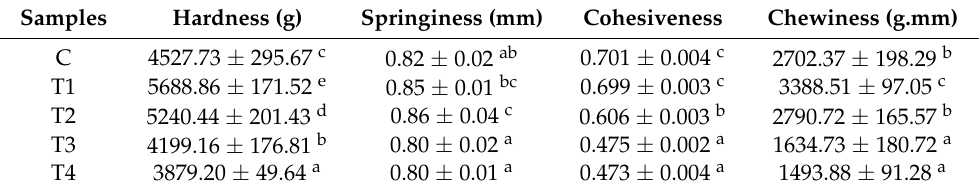
Table 5. Textural properties of cooked lower-fat meat batters prepared with various amounts of ORP. Samples Hardness (g) Springiness